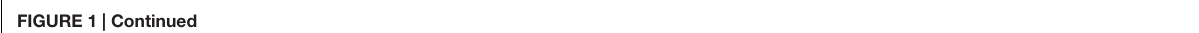
FIGURE 1 | Continued domains of the PKS modules are marked in blue, red, and green, respectively. Black bars above the proteins represent the 50 regions that form, together with the modifying enzymes, the 63 fragment pool used in Y2H analysis, covering the entire biosynthesis cluster. Modifying enzymes BatA-E assemble into a β -methyl incorporation cassette (pink) that acts four times during assembly of kalimantacin on the sites indicated with a pink star. BatH and BatJ deliver the acetyl- and malonyl-CoA building block to the initiation and elongation modules. BatK, BatF and BatM reduce a double bond, transfer a carbamoyl group and perform oxidation of a hydroxyl group, respectively. New building blocks are illustrated in blue on the molecule’s backbone, while alterations done by modifying enzymes are marked in